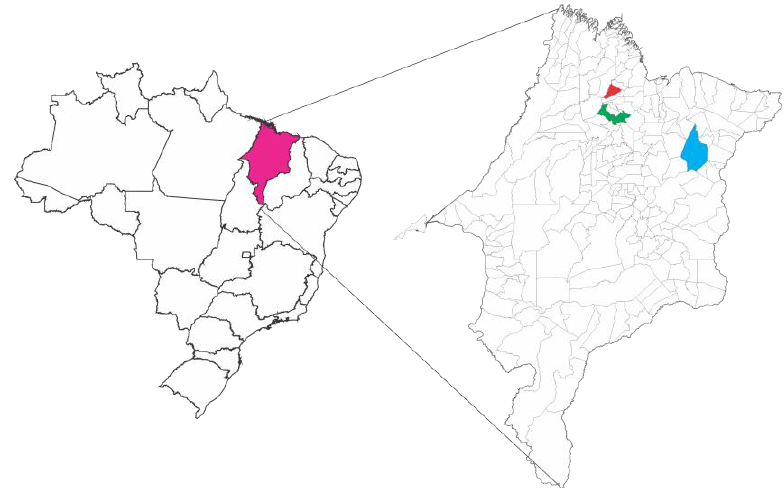
Figure 10. Localization of Maranhão State (in magenta) and the cities of Chapadinha (in blue), Palmeirândia (on red) and Viana (on green).